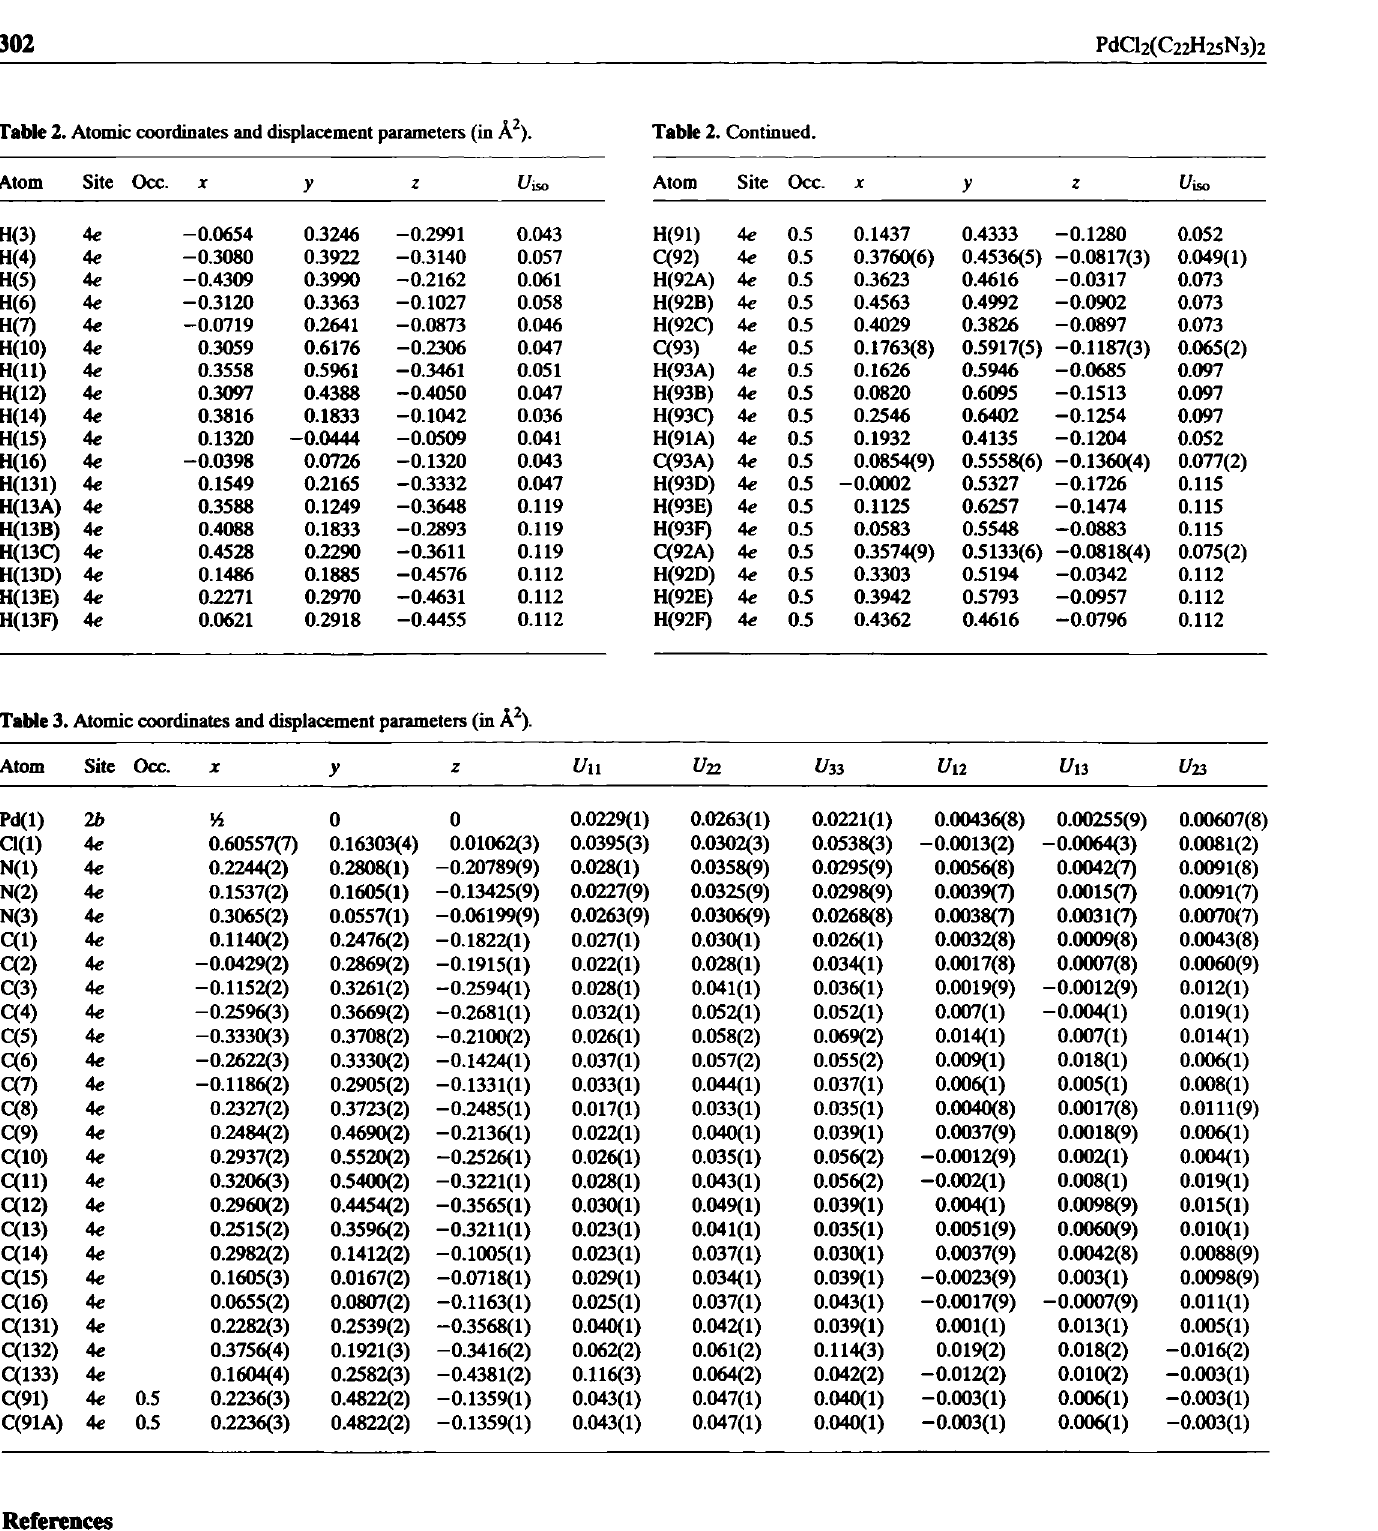
Table 2. Atomic coordinates and displacement parameters (in A 2 ).